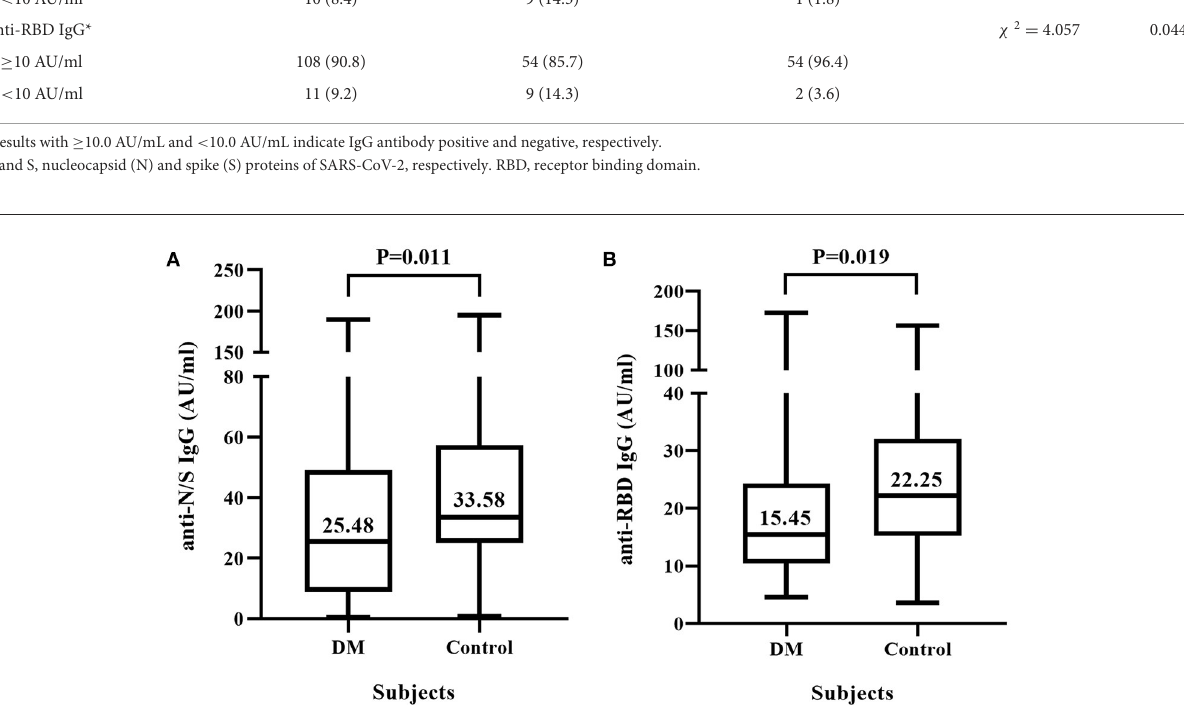
The comparison of antibody titers between the T2DM patients with controlled and uncontrolled glycemia and the non-T2DM individuals showed that the median levels of anti- N/S IgG and anti-RBD IgG in the patients with fasting blood glucose ≥ 7 mMol/L were much lower than those in the patients with fasting blood glucose < 7 mMol/L, respectively (anti-N/S IgG: 13.30 vs. 33.65 AU/ml, P = 0.006; anti-RBD IgG: 11.91 vs. 19.83 AU/ml. P = 0.023), and significantly lower than those in the non-T2DM individuals (anti-N/S IgG: 13.30 vs. 33.58 AU/ml, P < 0.001; anti-RBD: 11.91 vs. 22.25 AU/ml. P = 0.001) (Figures 2B,C). However, the